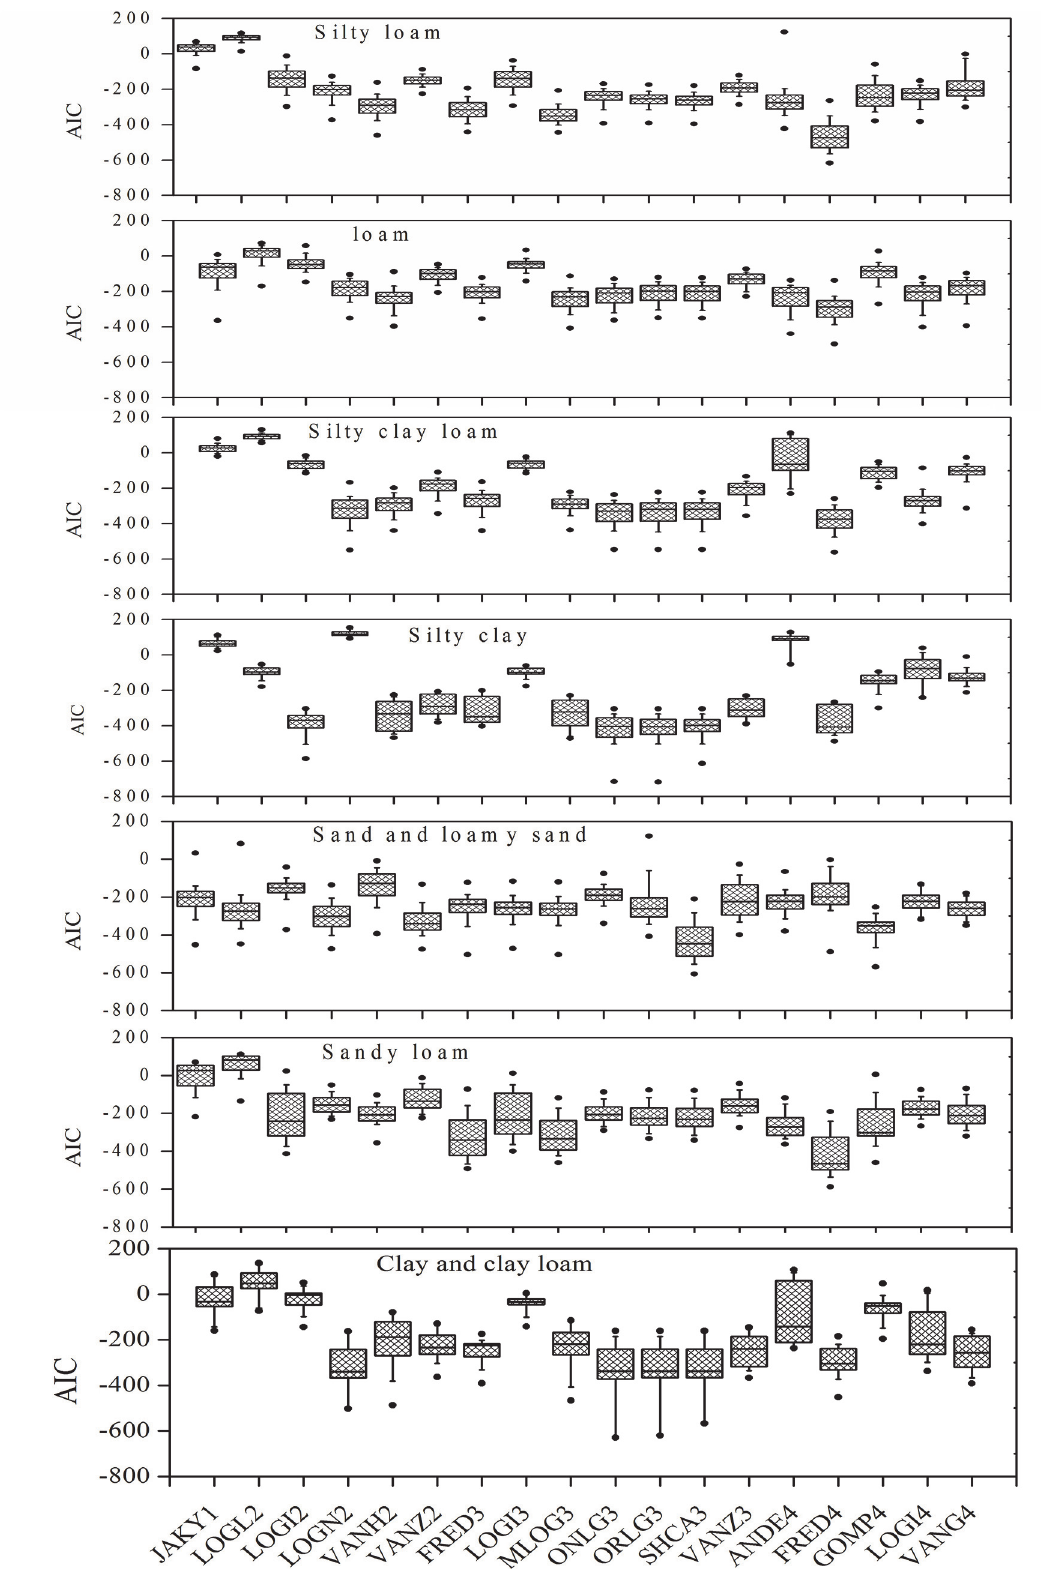
Fig 8. Box plots showing AIC for eighteen particle size distribution functions across different soil texture classes.